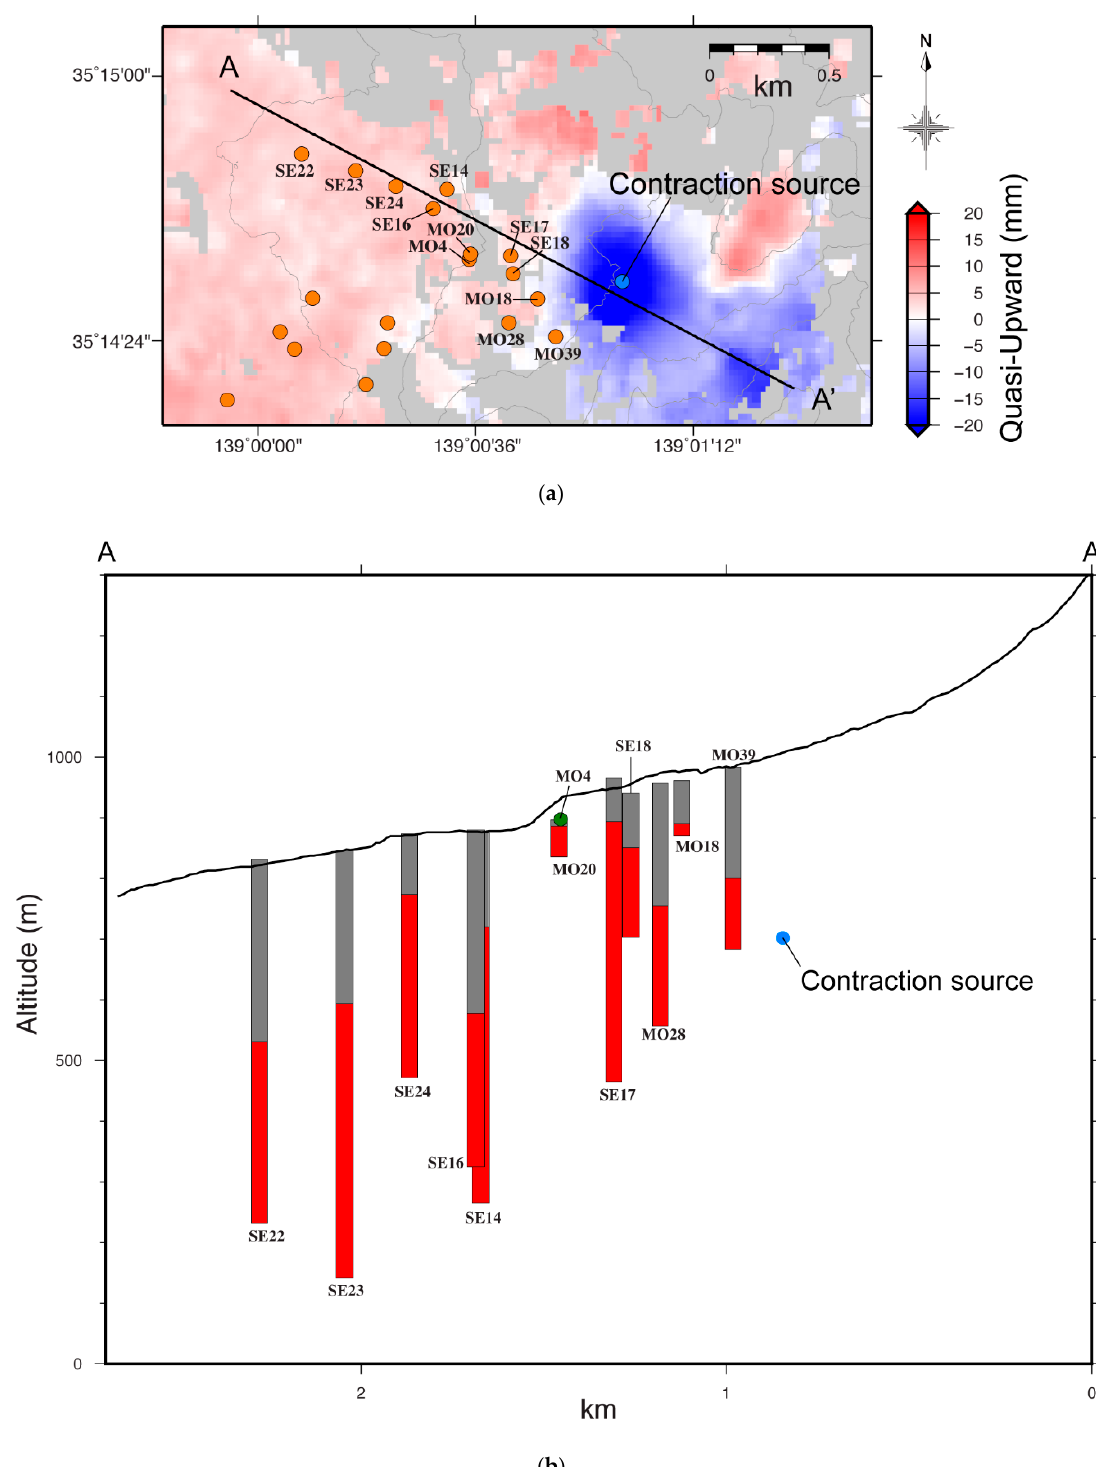
Figure 12. Characteristics of the hot spring wells to the west of Owakudani as ( a ) a horizontal distribution of hot spring wells (orange-colored points) on the map of quasi-upward velocity; ( b ) cross-section indicated by A-A’ in ( a ). Contour lines in ( a ), in which intervals are 100 m, were extracted from 10 m mesh height data released by the GSI. MO (Motohakone) and SE (Sengokuhara) indicate the numbers of hot spring wells managed by the Odawara Health and Welfare Office. Gray and red colors in ( b ) show the extent of cased and uncased parts of the borehole, respectively. MO4 is a natural hot spring at the